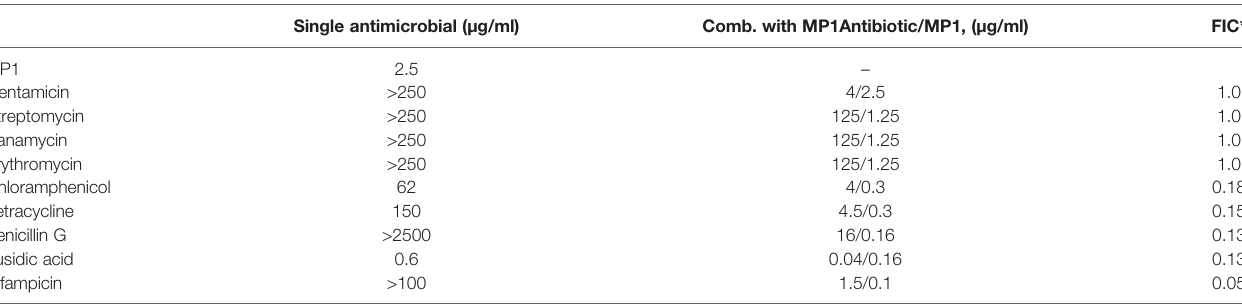
TABLE 4 | Synergy assessment between MP1 and a panel of antibiotics against MRSA Xen31. Single antimicrobial (µg/ml) Comb. with MP1Antibiotic/MP1,